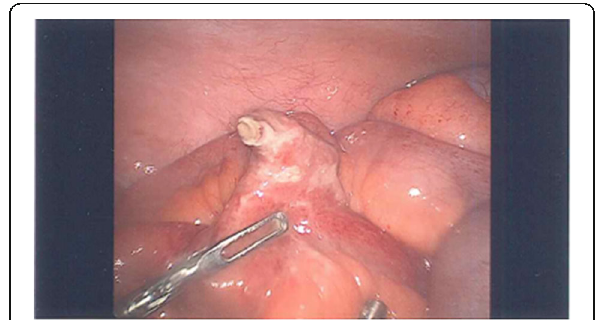
Fig. 3 Laparoscopic view of the perforated MD by chicken